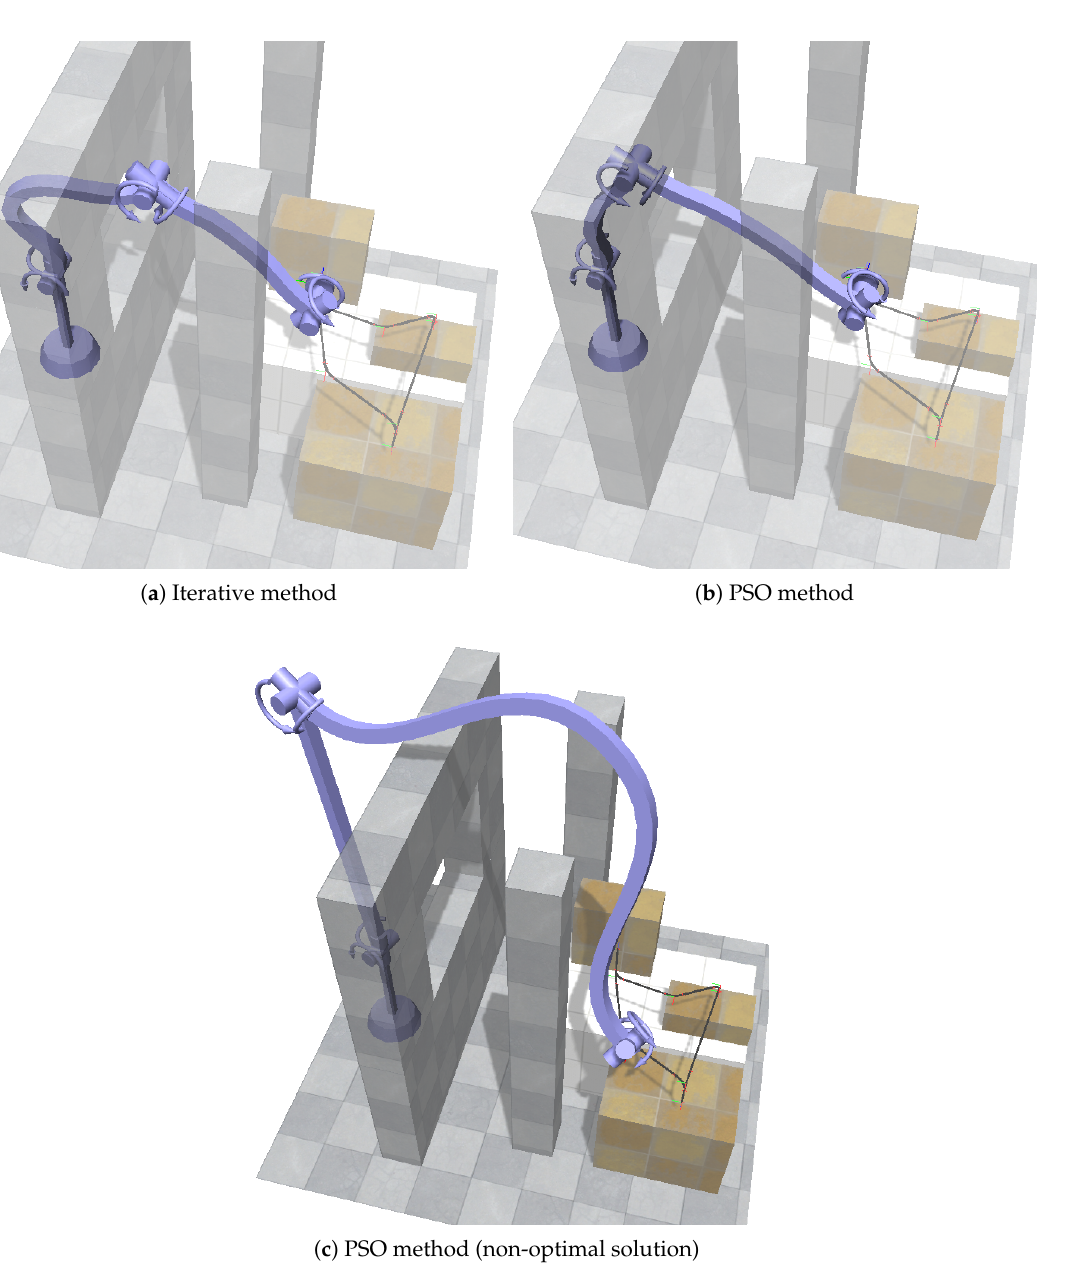
Figure 14. Results for the third testing